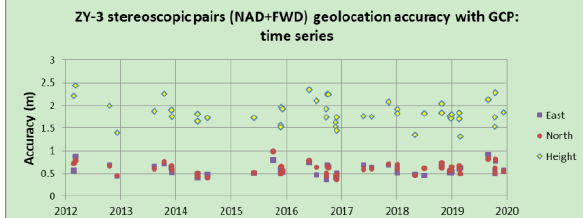
Figure 17. ZY-3 stereoscopic pairs (NAD+FWD) geolocation accuracy with GCP